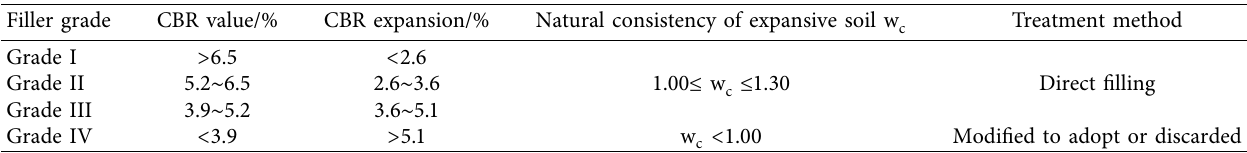
> 1 . 30, preferably they are not adopted). c